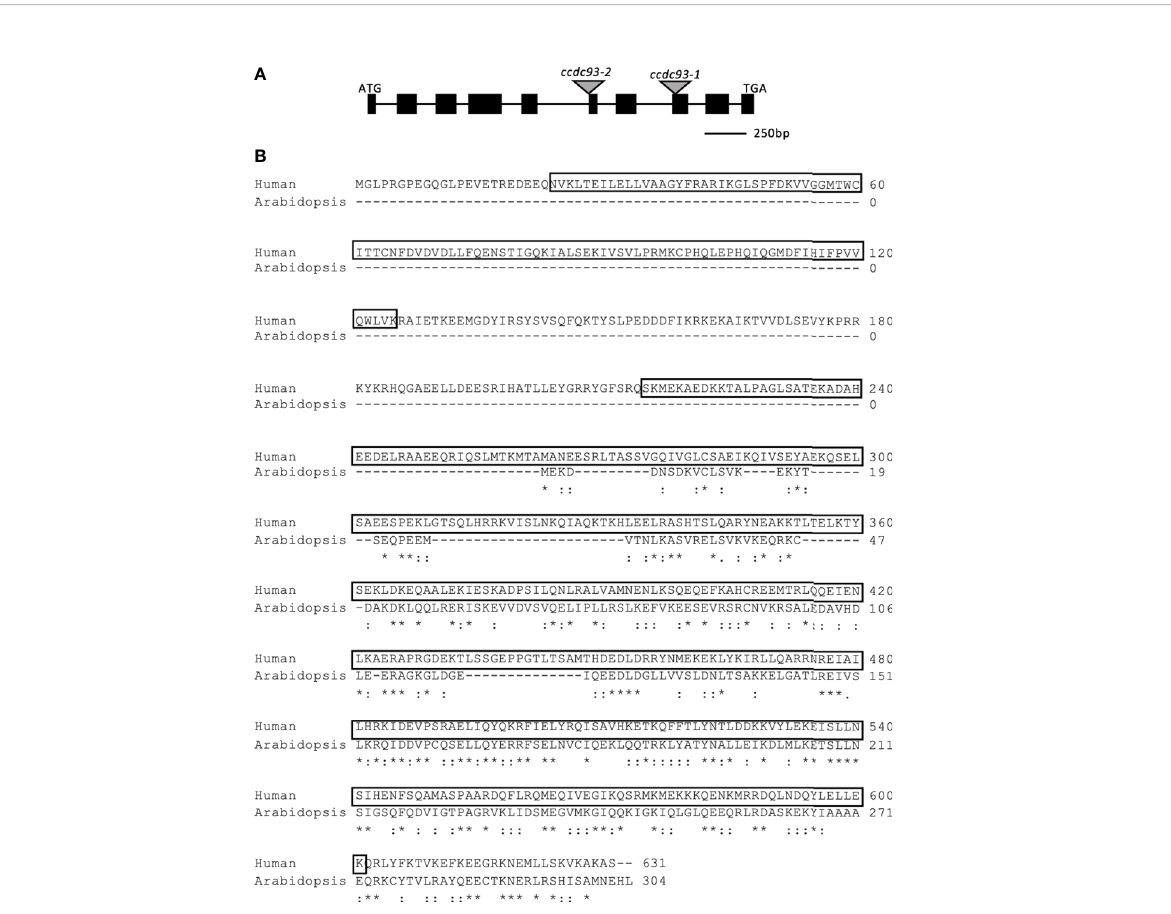
FIGURE 2 Gene model for Arabidopsis thaliana CCDC93 . (A) Gene model for ATCCDC93 as determined by aligning the ATCCDC93 genomic sequence with sequenced, full length CCDC93 cDNA. The black boxes correspond to exons and the lines introns. The gray triangles show the locations of the integration events of the indicated T-DNA insertion lines. Image is drawn to scale. (B) Human and Arabidopsis CCDC93 Protein Alignments. ATCCDC93 cDNA sequence was translated in silico and aligned to HSCCDC93 amino acid sequence. The boxed amino acids correspond to the N-terminal NN-CH domain and the C-terminal coiled-coil domain. ATCCDC93 displays 55% amino acid similarity with the C-terminal half of HSCCDC93. *represents identical amino acids,: represents similar amino